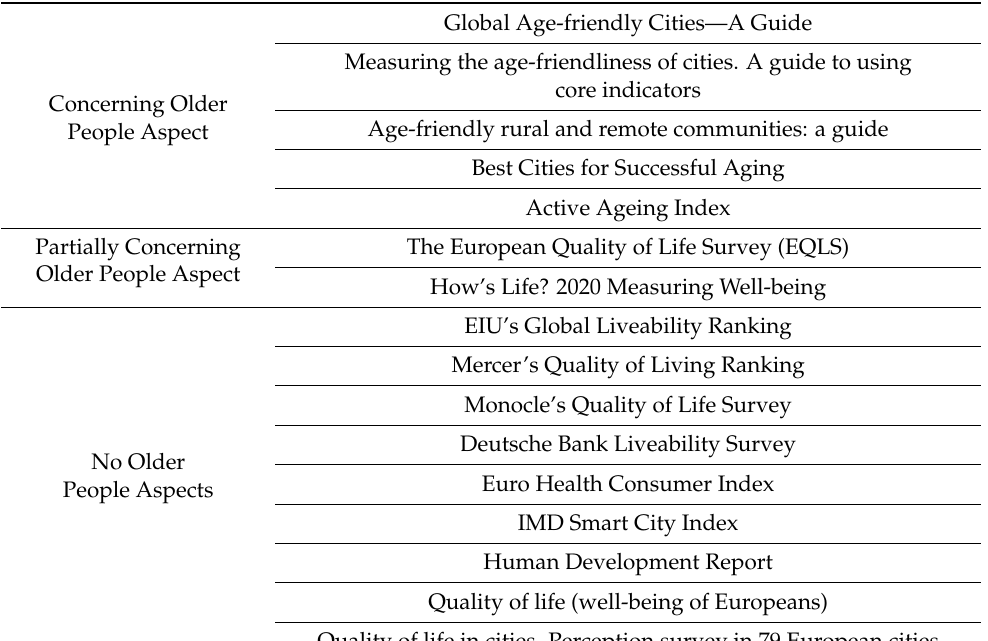
Table 4. Classification of tools. Aspect of an aging